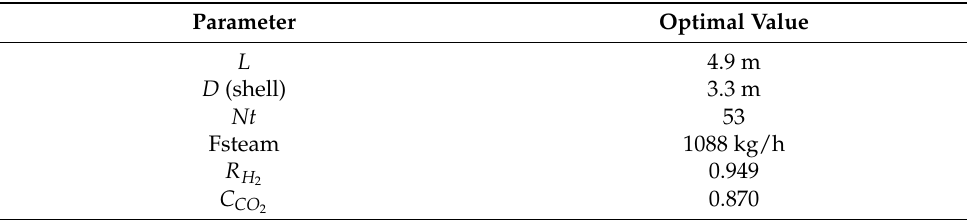
Table 2. Optimal membrane reactor design that produces the “best tradeoff” between hydrogen recovery and carbon capture according to the defined objective in Equation